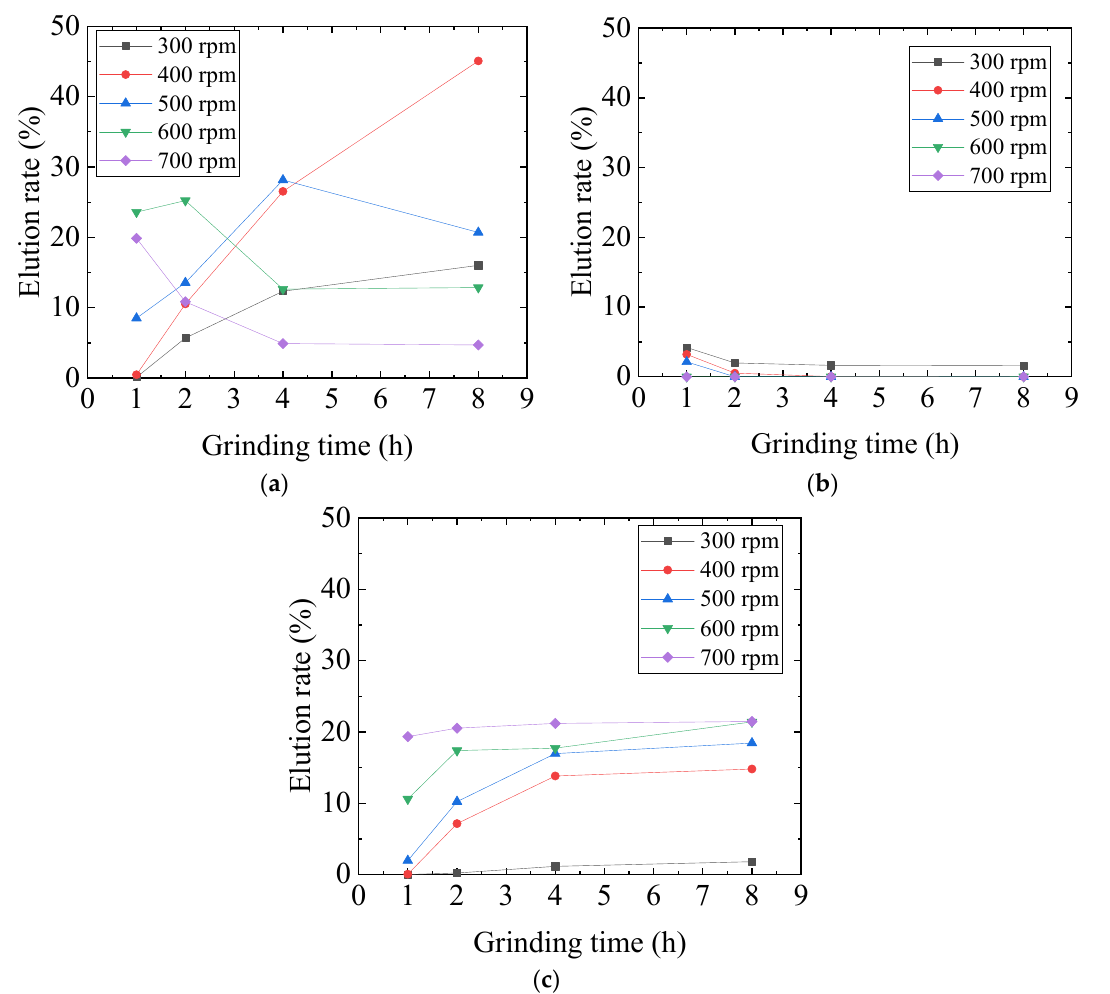
Figure 7. Elution rate of ( a ) As, ( b ) Cu and ( c ) Fe from combined ground samples at different rotational speeds. Table 2. Summary of the optimization of grinding conditions. The elution rate of As, Cu and Fe from combined ground samples using different ball diameters, grinding times, rotational speeds, andtype and concentration of solvent.